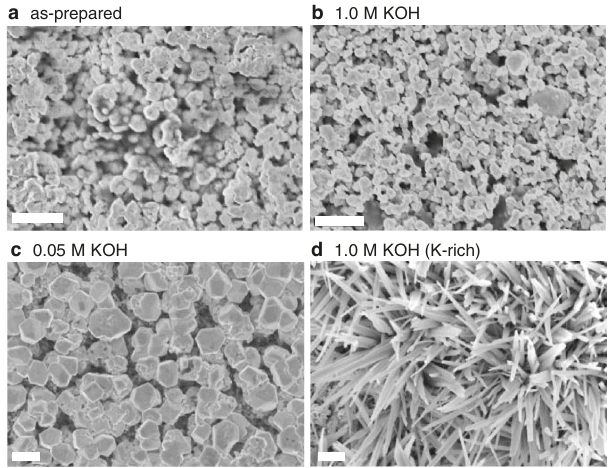
Fig. 3 | Cathode morphology and structure. SEM images of the Cu cathode sur- face before ( a ) and after testing in zero-gap electrolyzers under 3.2V bias using anolytes of b 1.0M KOH and c 0.05M KOH. d Area rich in K-rich structures occurring on the part of the surface tested using 1.0M KOH. Scale bars: 1 µ m. Supplementary Fig. 6 provides cross-section images with elemental mapping.